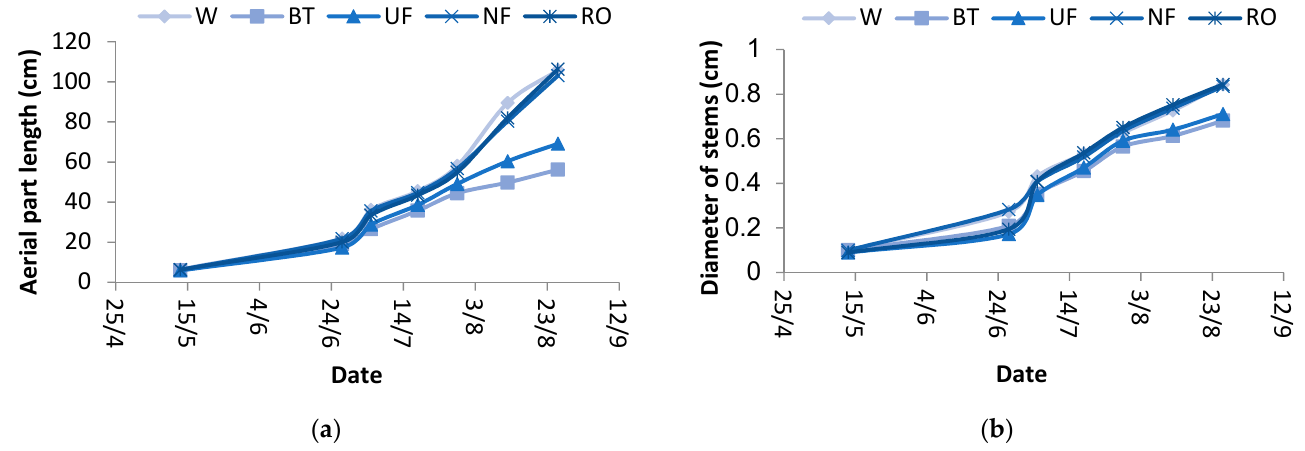
Figure 2. Growth evolution of the aerial parts of Sesbania bispinosa . ( a ) Aerial part length; and ( b ) diameter of stems. W: Well water; BT: Biological treatment; UF: Ultrafiltration; NF: Nanofiltration; and RO: Reverse Osmosis.